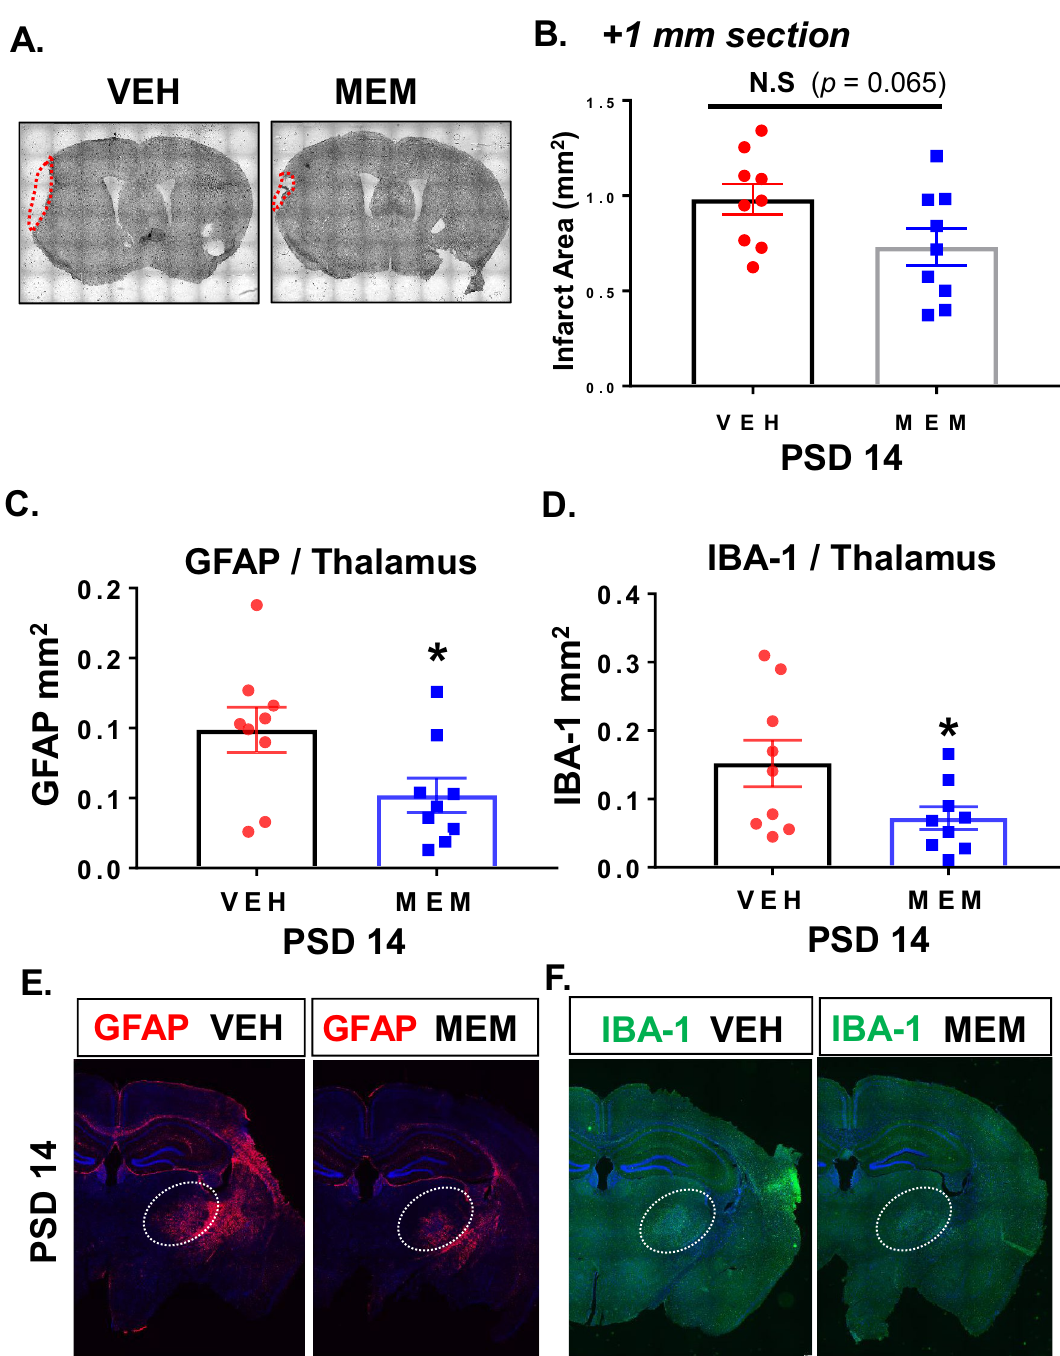
Figure 8. Memantine, an NMDA antagonist reduced glial activation in thalamus after stroke. Post- stroke treatment with memantine, an NMDA receptor antagonist, reduces gliosis in ipsilateral thalamus. Representative images showing CV staining ( A ) and infarct volume quantification at + 1 mm section ( B ) at PSD 14 for memantine and vehicle treated mice. Primary cortical infarct volume was not significantly changed with memantine treatment (n = 9, P = 0.065, unpaired t test). Thalamic area demonstrating GFAP expression ( C,E) and IBA-1 expression ( D,F ) was significantly reduced at PSD 14 with memantine treatment. * P < 0.05, unpaired t